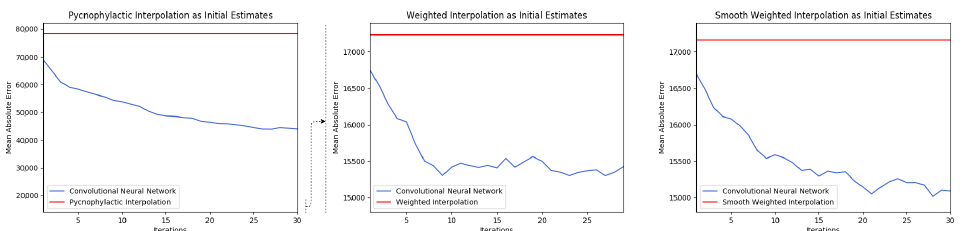
Figure 6. Error values when using different heuristics for producing the initial estimates in the proposed self-training approach for the overall amount of national